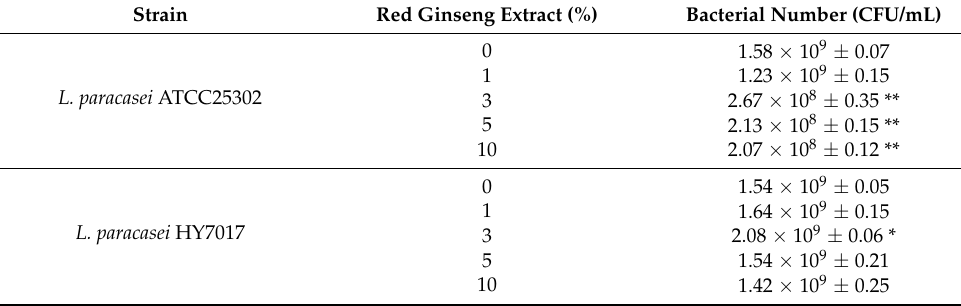
Table 1. The bacterial number of Lactobacillus paracasei strains in MRS according to RGE content. Strain Red Ginseng Extract